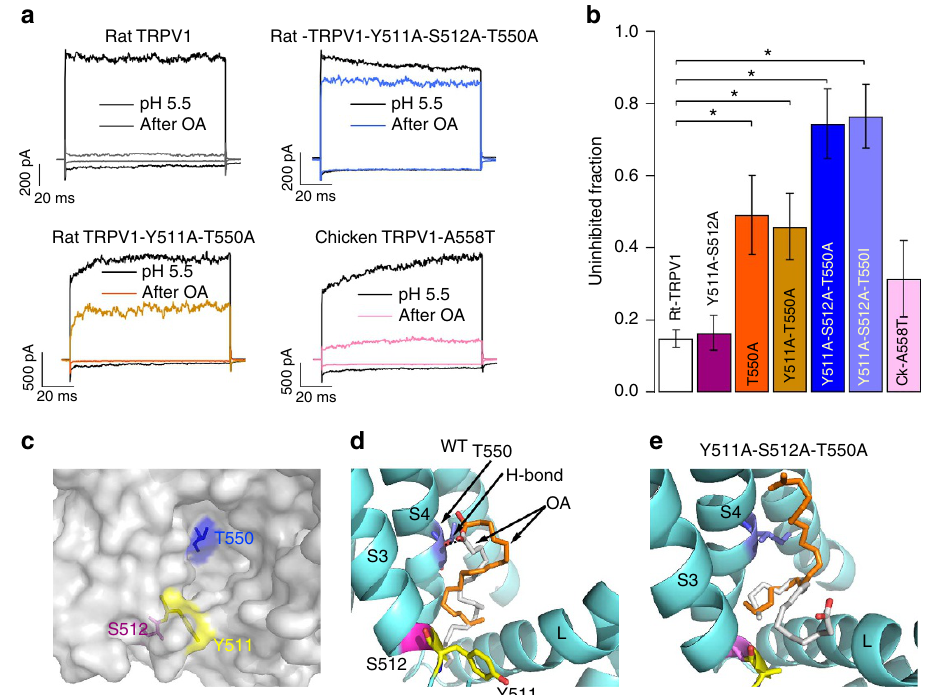
Figure 5 | Oleic acid binds to the VBP of TRPV1. ( a ) Representative traces obtained from outside-out membrane patches as in Fig. 2. Currents are from WT rTRPV1, rTRPV1-Y511A-T550A, rTRPV1-Y511A-S512A-T550A and CkTRPV1-A558T channels. Black traces were obtained in response to pH 5.5, and turquoise, gold, blue and pink traces were obtained in the presence of pH 5.5 after 3min of 5 m M OA. ( b ) Fraction of remaining currents after OA as normalized to the initial current in the presence of pH 5.5; rTRPV1 ( n ¼ 22); rTRPV1-Y511A-S512A ( n ¼ 10); rTRPV1-T550A ( n ¼ 14); rTRPV1-Y511A-T550A ( n ¼ 8); rTRPV1-Y511A-S512A-T550A ( n ¼ 9), rTRPV1-Y511A-S512A-T550I ( n ¼ 11) and CkTRPV1-A558T ( n ¼ 15) * P o 0.001 between groups as compared by brackets. ( c ) Surface representation of vanilloid-binding site (VBP) in the closed state structure (PDB 3J5R). A cavity is visible and the location of mutated residues is indicated: T550 (blue), Y511 (yellow) and S512 (magenta). ( d ) Docking calculation showing two representative protonated